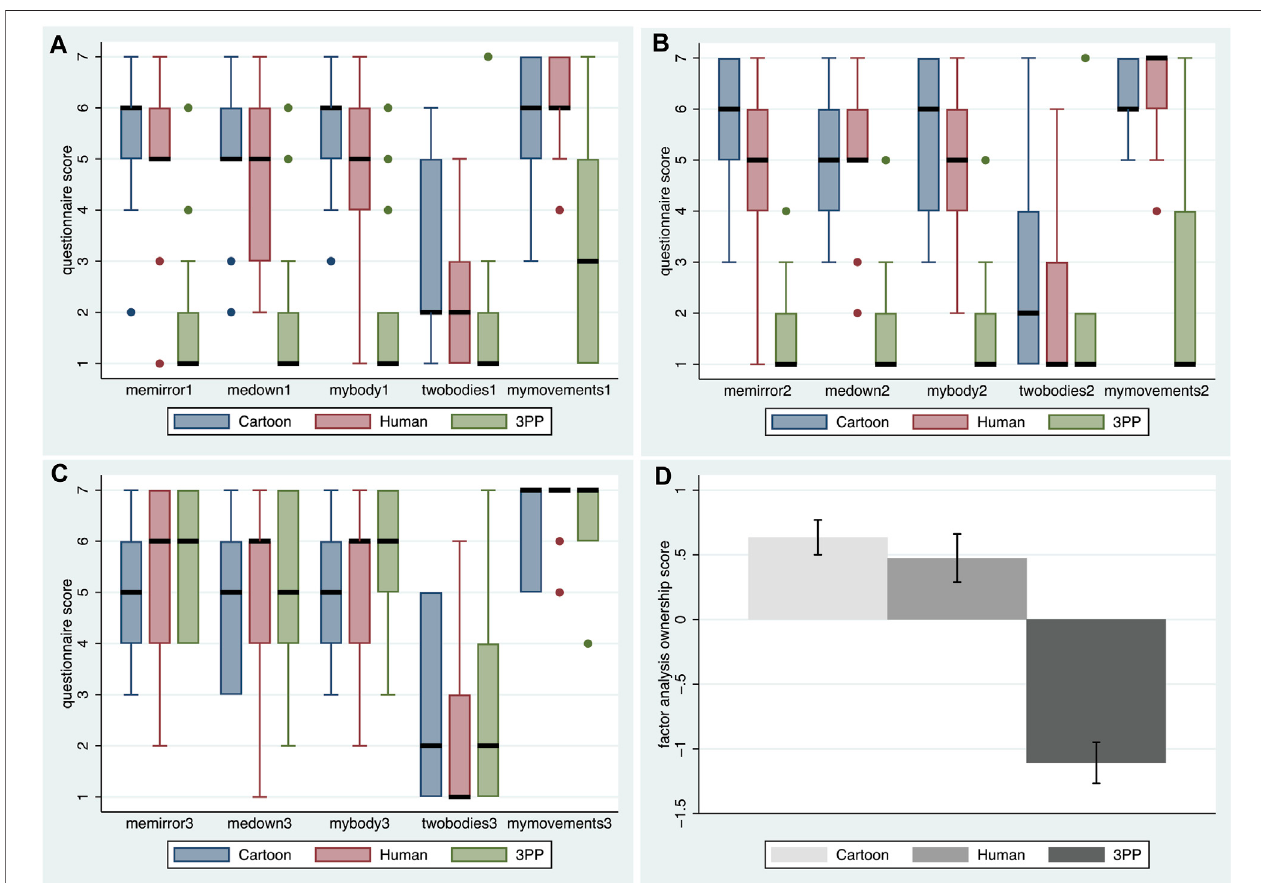
FIGURE 2 | Scores on the ownership questions from Table 1 . (A) Box plot for exposure 1, session 1. (B) Box plot for exposure 2, session 1. (C) Box plot for the exposureembodiedasHumanforsession2,butwheretheconditionsrefertothoseofsession1. (D) Barchartsshowingmeansandstandarderrorsofthefactorscores from the principal component factor analysis of the ownership scores of the fi rst two exposures only.